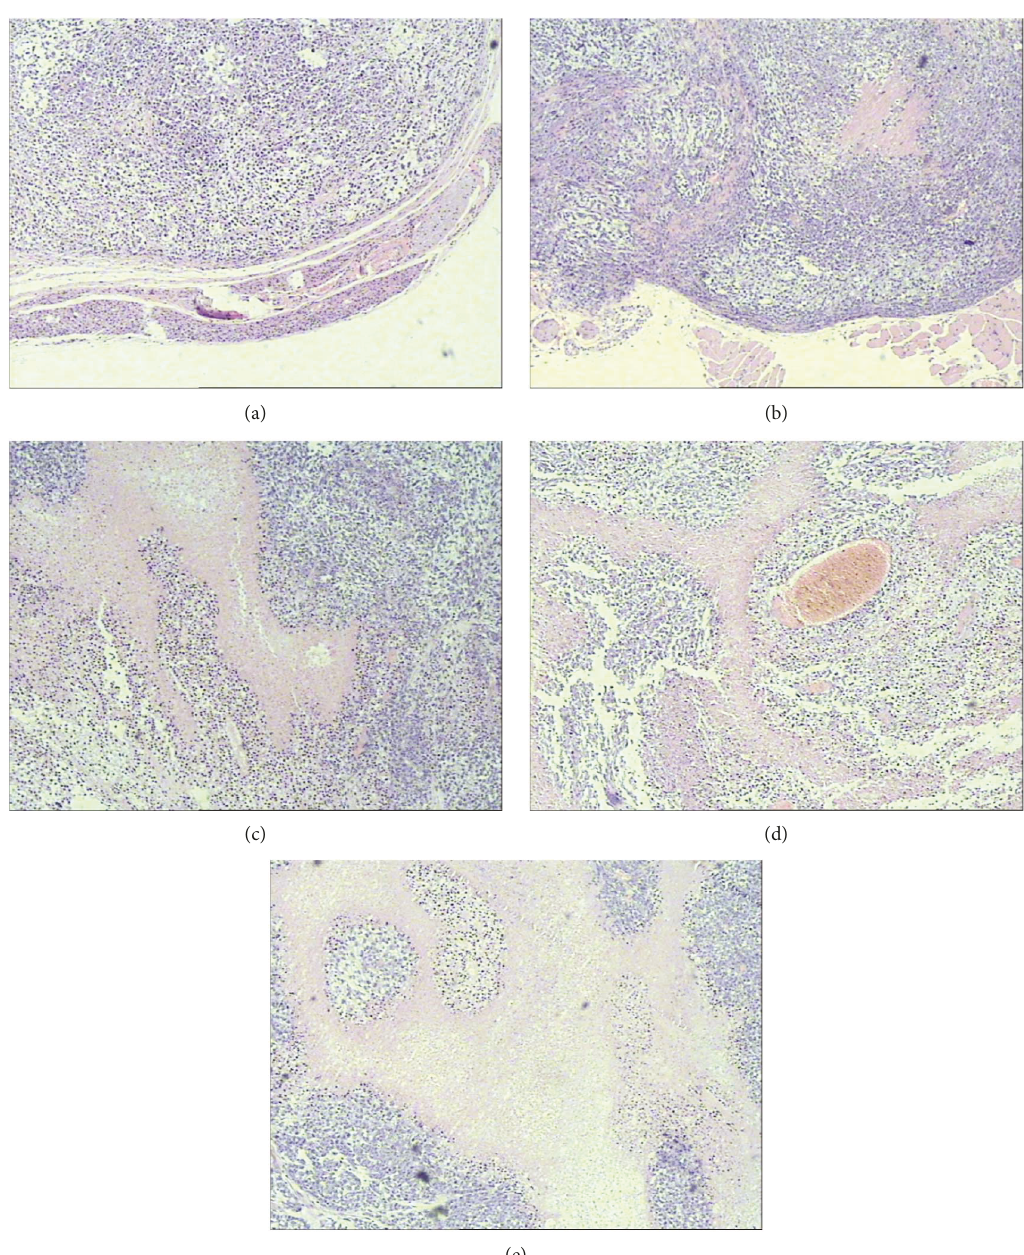
Figure 11: Xenograft hepatoma histopathological fi ndings after di ff erent treatments (stained with HE, × 100). (a) Saline control group. (b) Radionuclide group. (c) MFH group. (d) Radionuclide-gene group. (e) Radionuclide-gene-MFH